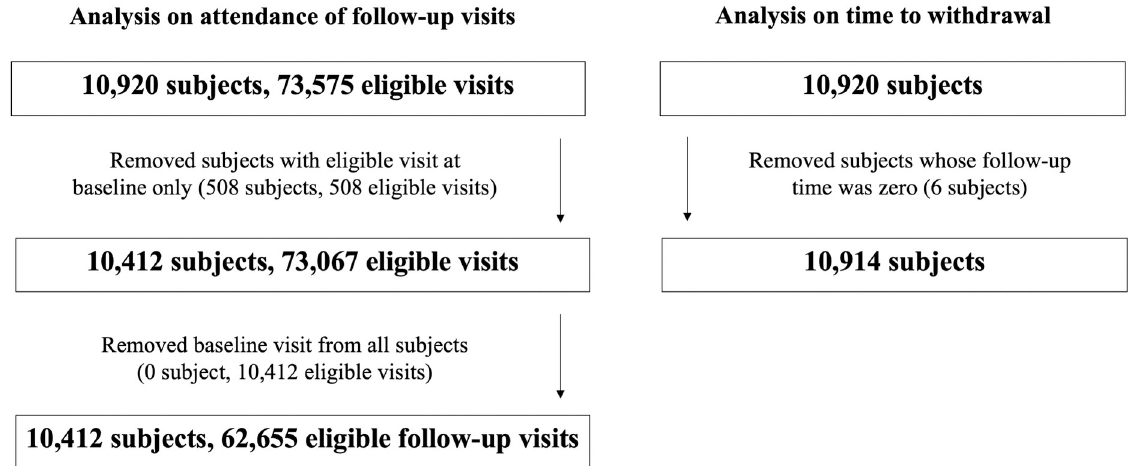
Fig 1. Sample size flow